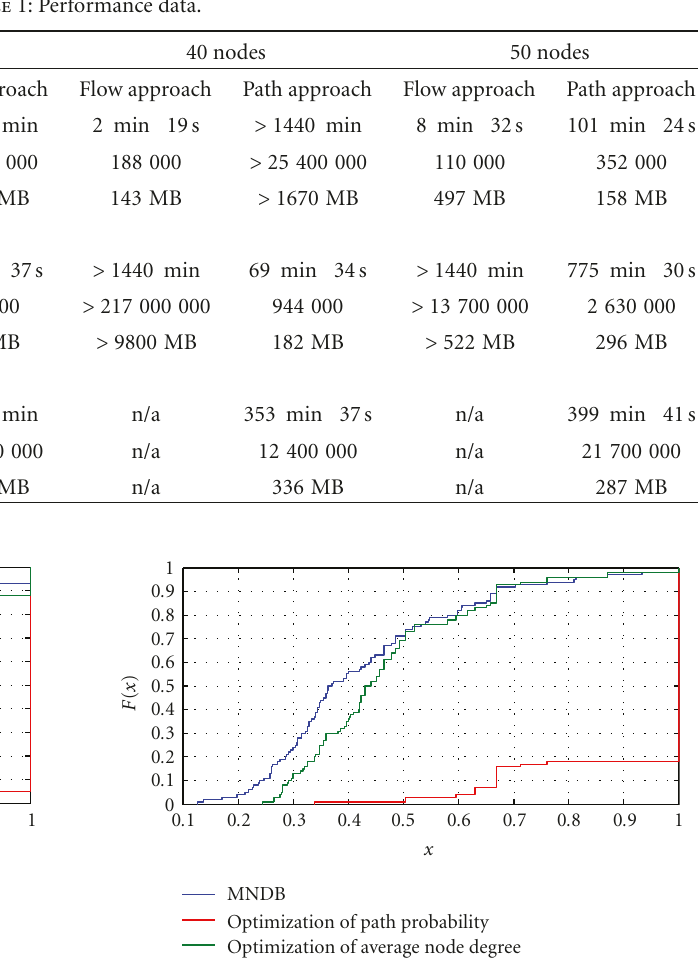
Figure 11: CDF of path probability, comparison of MNDB, optimization of path probability, and optimization of average node degree, P t = 18dBm